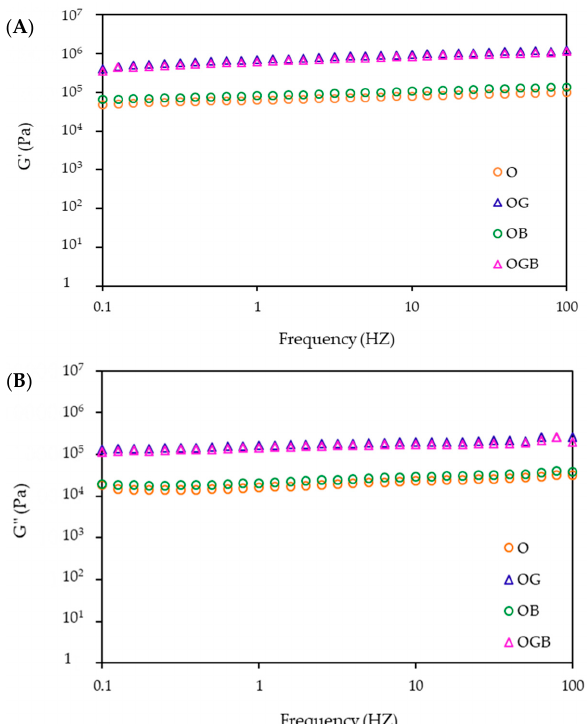
Figure 2. Dynamic viscoelastic properties of oleogels as a function of frequency: ( A ) storage moduli and ( B ) loss moduli (O: oleogel, OG: oleogel + GMS, OB: oleogel + β -carotene, OGB: oleogel + GMS + β -carotene).